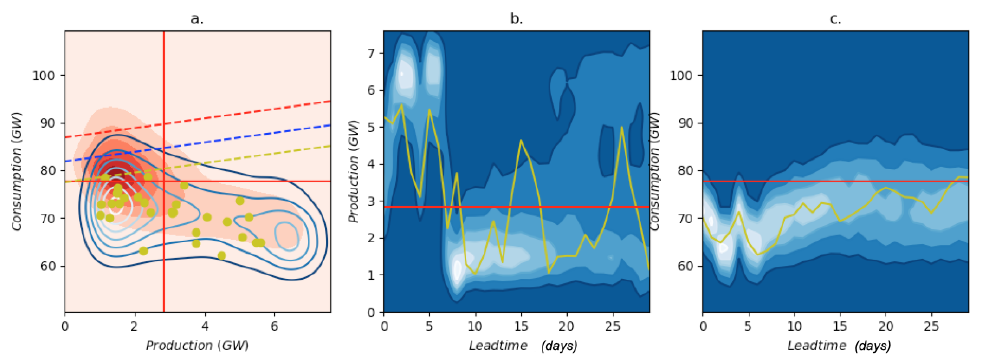
Figure 8. Forecast of January 2014 at the monthly horizon. ( a ) Reconstructed joint PDF (blue contour), real daily data (yellow dots) and the climatological PDF for January (red contour). ( b ) time series of the ensemble forecast of production (in blue contour) and of the real production (in yellow). ( c ) time series of the ensemble forecast of consumption (in blue contour) and of the real consumption (in yellow). The red line indicates the climatological value of production and consumption. The red, blue and yellow dashed lines indicate the extreme risk VaR 95 given by the climatology, the forecasted and the real PDFs